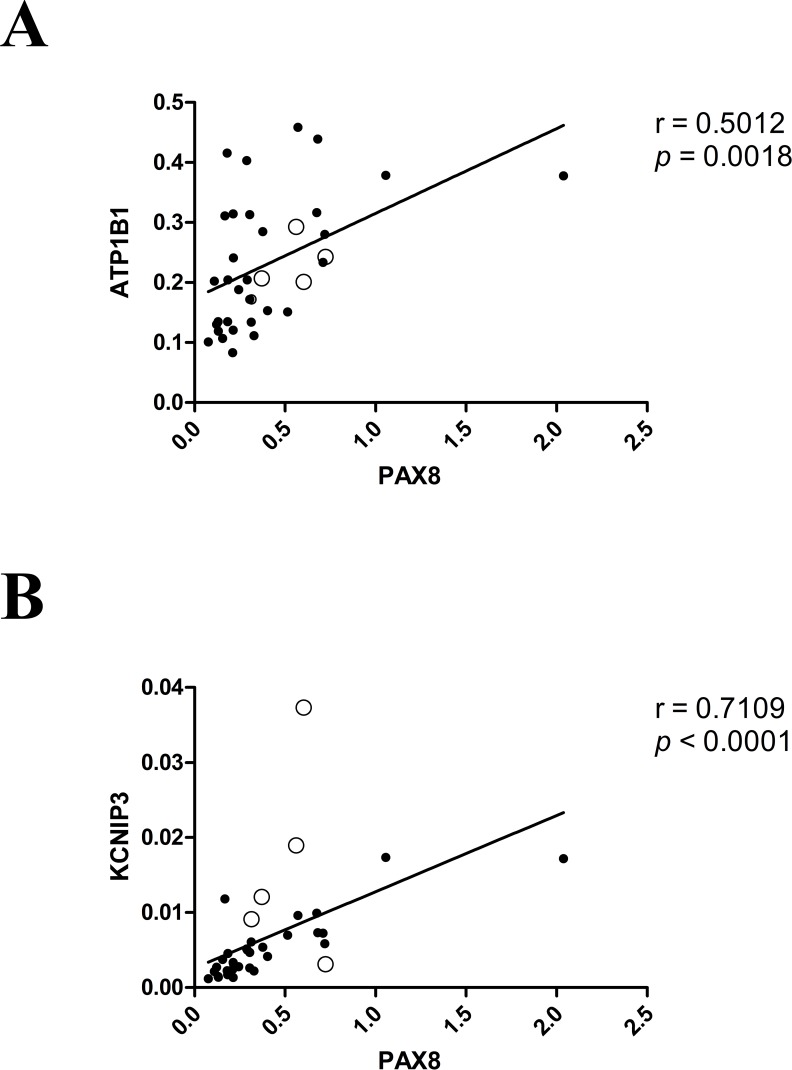
Putative PAX8 target genes whose mRNA levels were most strongly correlated with those of PAX8 in PTCs Levels of mRNA for ATP1B1 (A) and KCNIP3 (B) are plotted against PAX8 mRNA levels measured in 31 CT-PTCs (•) and 5 FV-PTCs (○). R and p values were calculated with the Spearman rank correlation test.